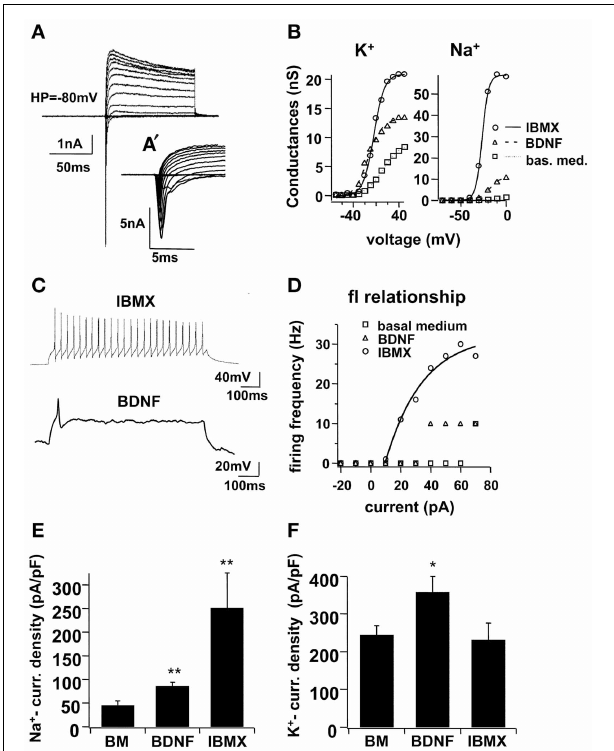
FIGURE 2 | Electrophysiological maturation of NPCs in high cAMP (IBMX), with voltage-dependent ionic currents and action potentials. In (A) , voltage clamp recordings on NSCs differentiated for 7 days in IBMX. Holding potential − 80mV, 100ms pulse duration from − 70 to 70mV at 10mV increments, with an average of 5 consecutive sweeps. Leak and capacitive currents were subtracted using a P/-4 protocol (see text). In (A (cid:5) ) ,